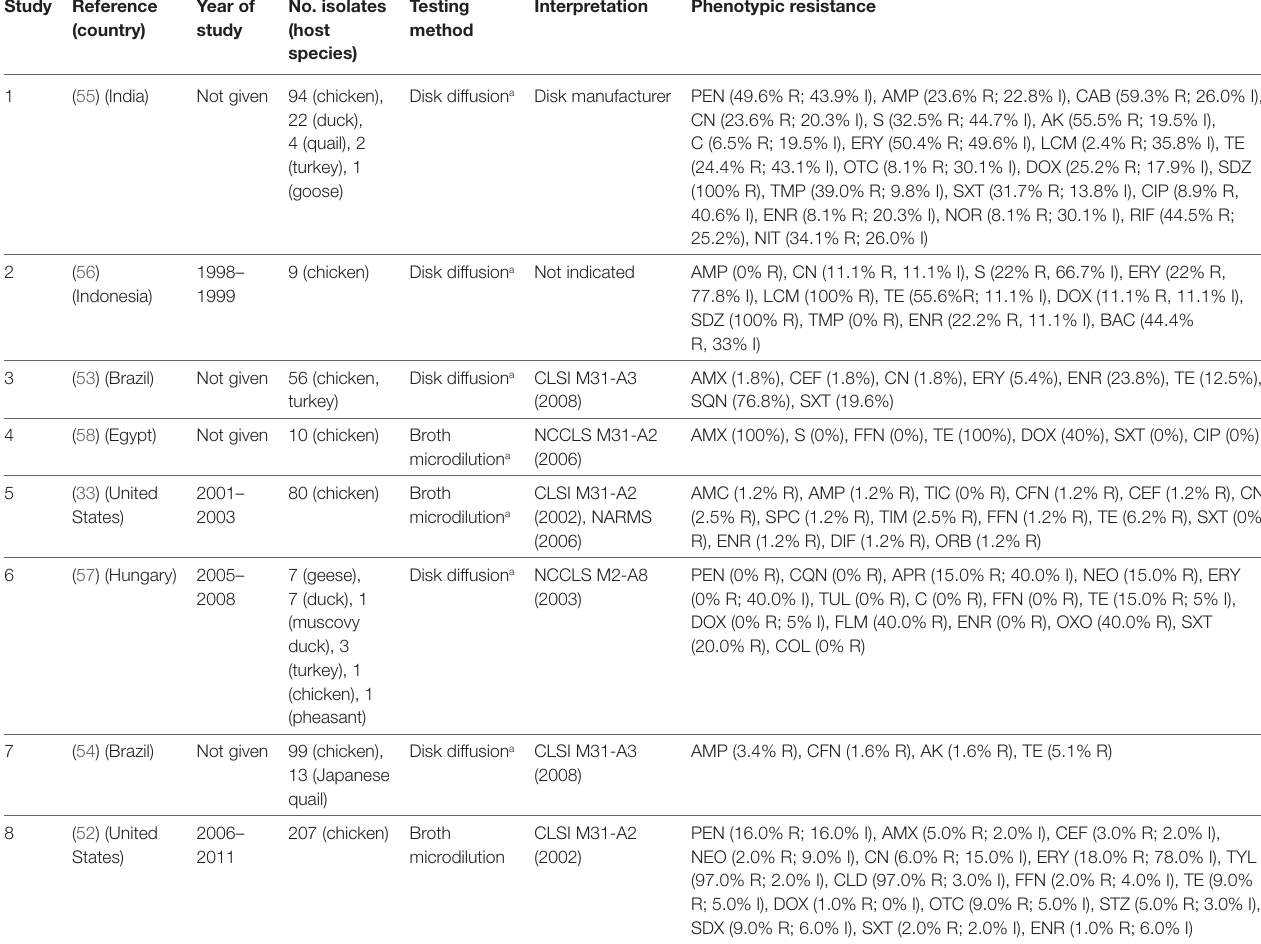
TABLe 3 | Summary of results of 8 phenotypic studies on antimicrobial resistance of P. multocida from poultry. Study Reference